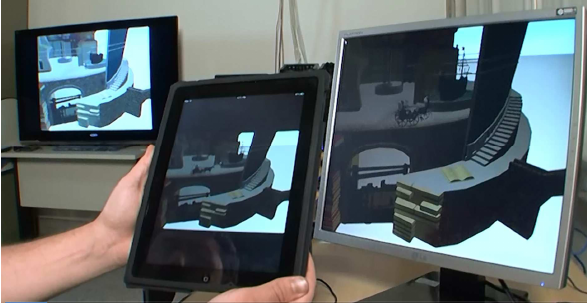
Fig. 11 – “Torre de Papel” in Digital TV (left) and tablet (center) and PC